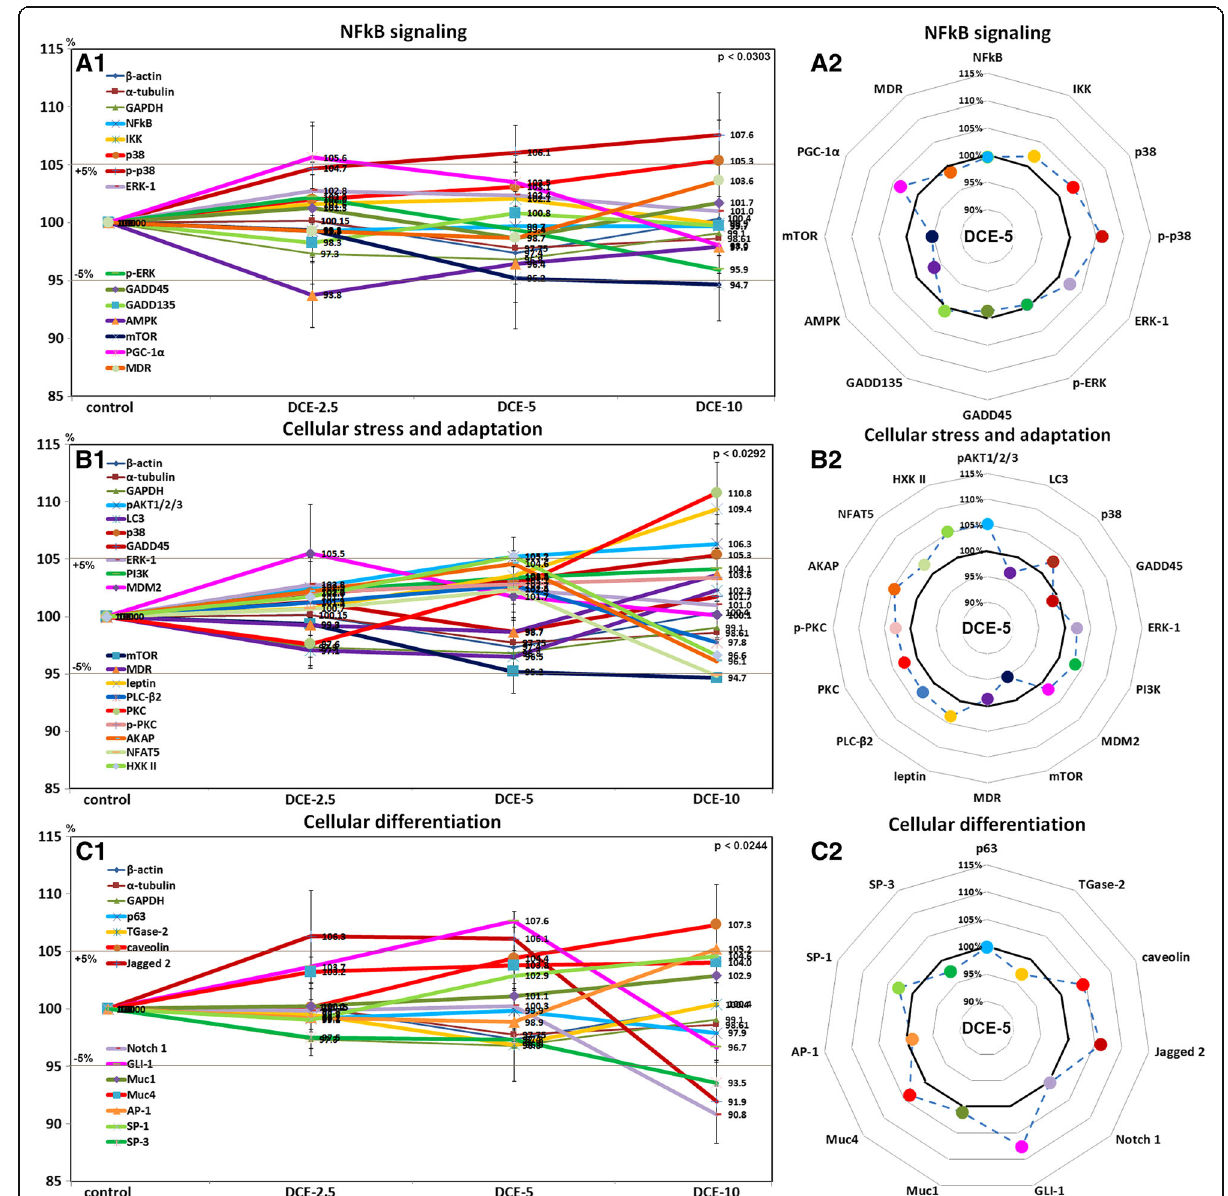
Fig. 5 Expressions of NFkB signaling ( a ), cellular stress and adaptation ( b ), and cellular differentiation ( c ) protein levels after DCE treatment in mouse livers as determined by IP-HPLC. Major protein expression pattern induced by DCE-5 was found in the radial graphs of A2, B2, C2, and